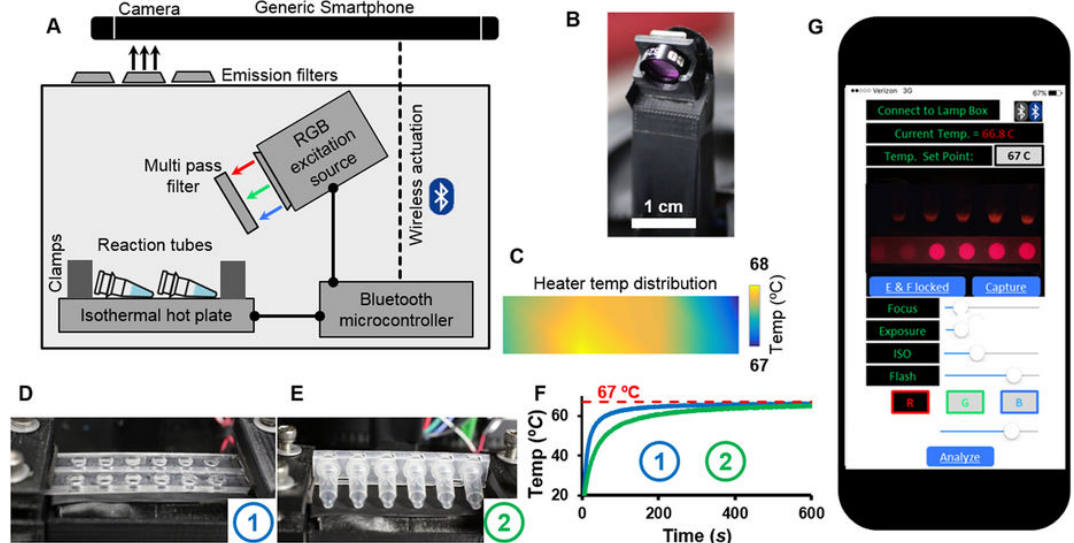
Figure 4. Zika virus sensor. ( A ) Test tubes placed on Isothermal hot plate are imaged using the smartphone camera with the LED acting as a light source. ( B ) Smartphone application interface. ( C ) Measured heat map of surface temperature indicating uniform heating with less than 1 ◦ C temperature variation. ( D ) Off the shelf PCR polypropylene tubes. ( E ) Custom made laser-cut reaction wells. ( F ) Measurements show improved thermal management with custom reaction wells. ( G ) Smartphone wirelessly controls the heating lamp and excitation source and is also responsible for capturing and analyzing illuminated reagents. Reprint adapted with permission from